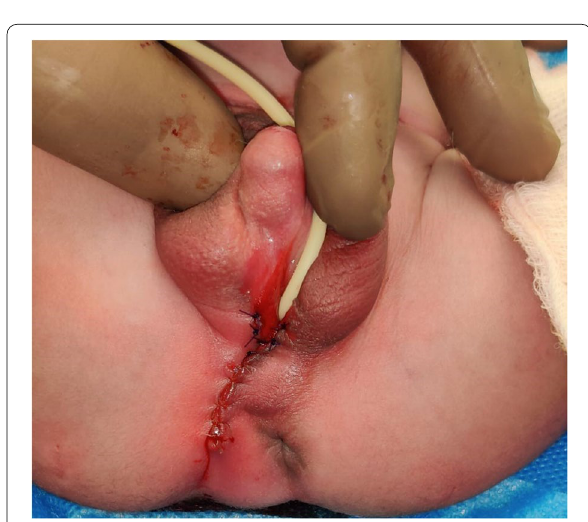
Fig. 5 Repaired perineum after excision of the bowel